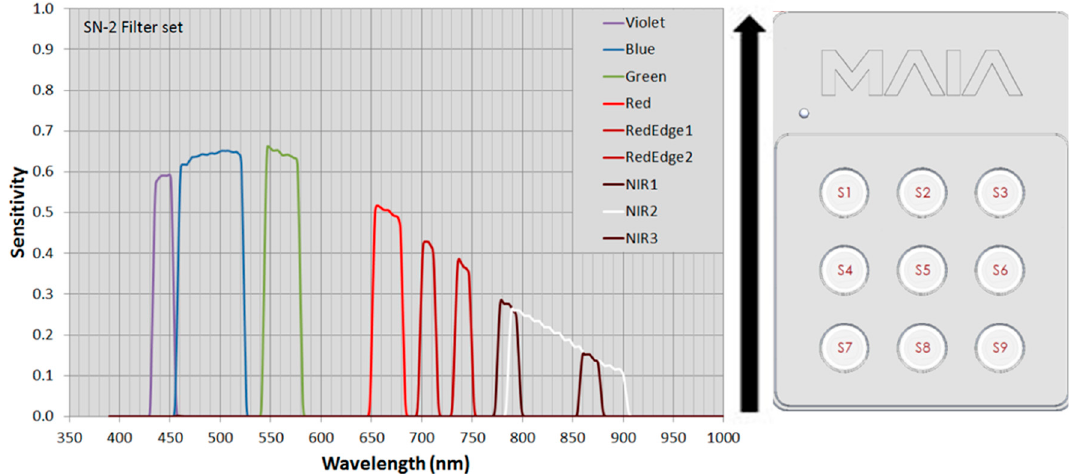
Figure 14. Sensitivity of the MAIA multispectral camera sensors (on the left) and their position (on the right) with respect to the acquisition direction (black arrow).